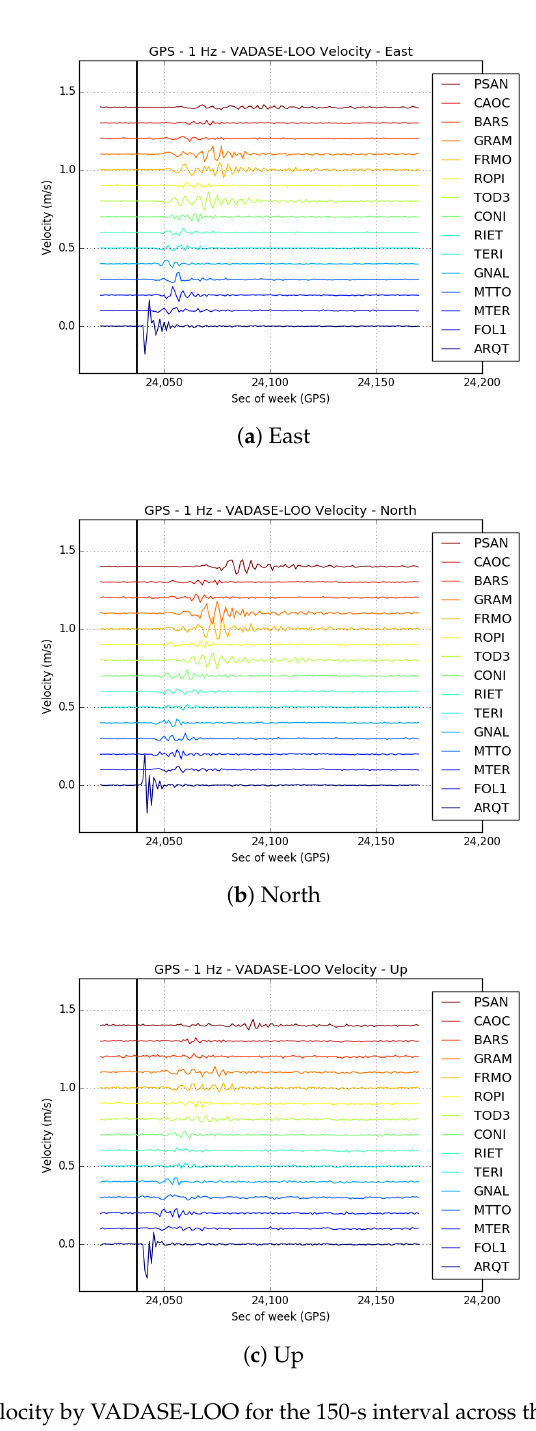
Figure 2. Estimated velocity by VADASE-LOO for the 150-s interval across the 30 October 2016 main shock (GPS